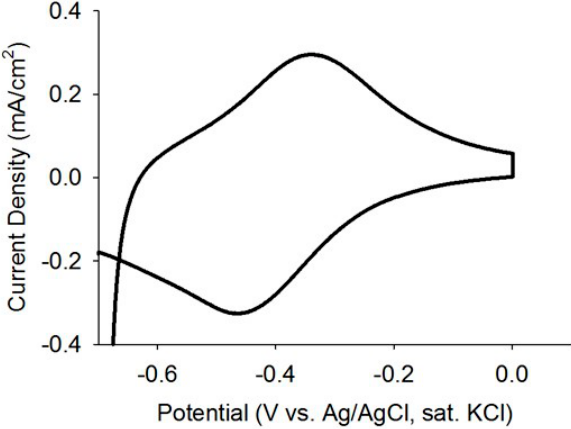
Figure 5. CV plot of the as-developed EABs with a scan rate of 1 mV/s.